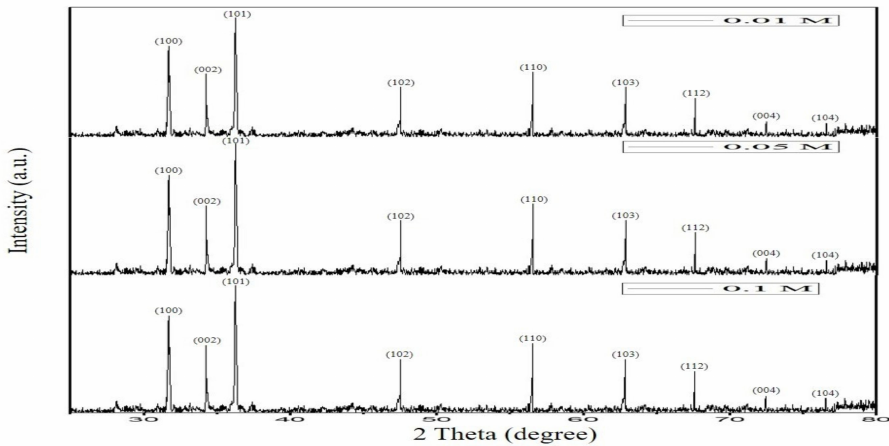
Figure 7. XRD pattern of 0.01M, 0.05M, and 0.1M biosynthesized ZnO NPsAL. Adapted from Umar et al. (2019)